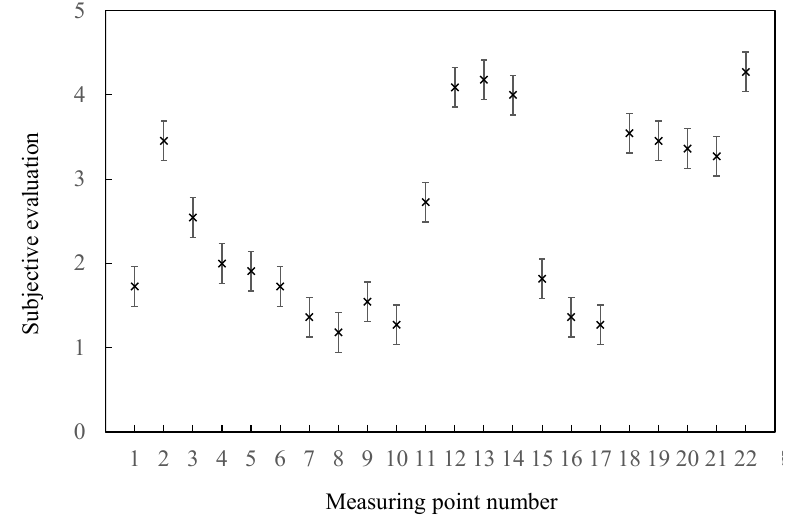
Figure 14. Subjective evaluation of each measuring point.